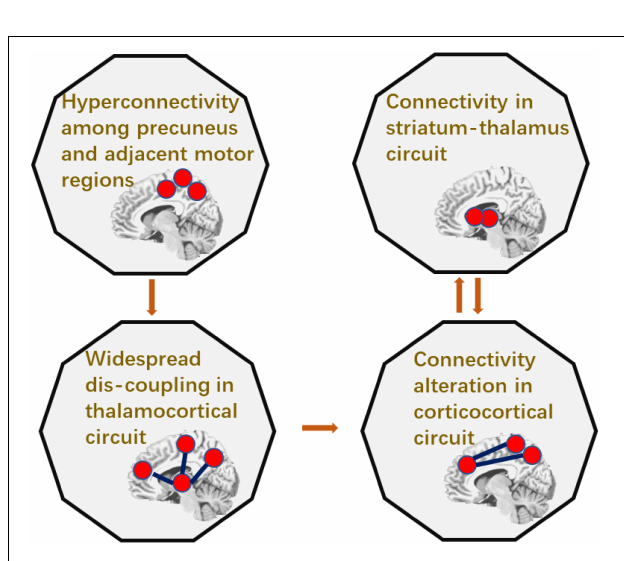
FIGURE 5 | The summarization of the causality in epileptic circuit.